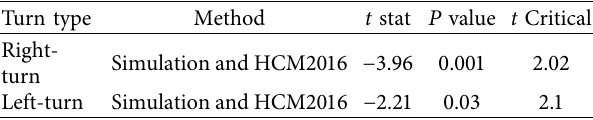
Table 5: t -test performed between the single and dual lanes. Turn type Method Right- Simulation and HCM2016 − 3.96 0.001 2.02 turn Left-turn Simulation and HCM2016 −